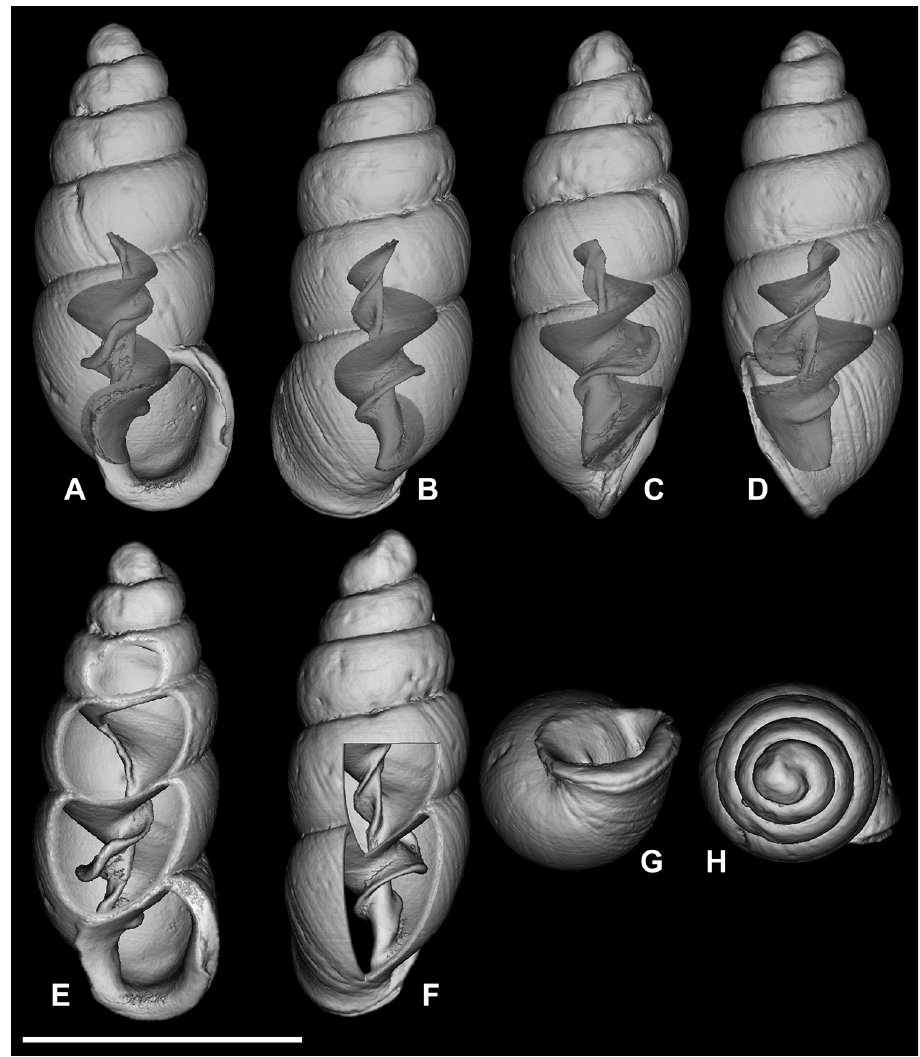
Figure 5. Carychium hardiei sp. n. A–F CT scans showing columellar apparatus of paratype (NMBE 549921/8) G umbilical view H aerial view of protoconch and spire. Scale bar 1